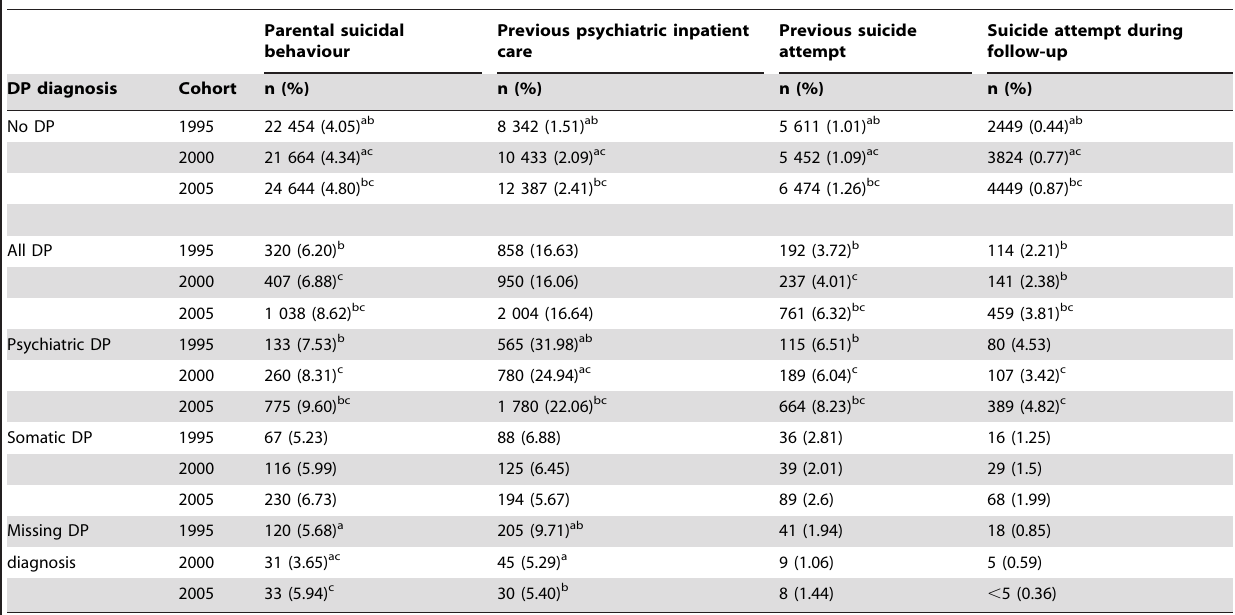
Table 3. Parental suicidal behaviour, own inpatient care due to psychiatric diagnoses, suicide attempt six years prior to baseline, and inpatient care due to suicide attempt during a five-year follow up in young adults (19–23 year) with and without disability pension (DP) in 1995, 2000 and 2005,